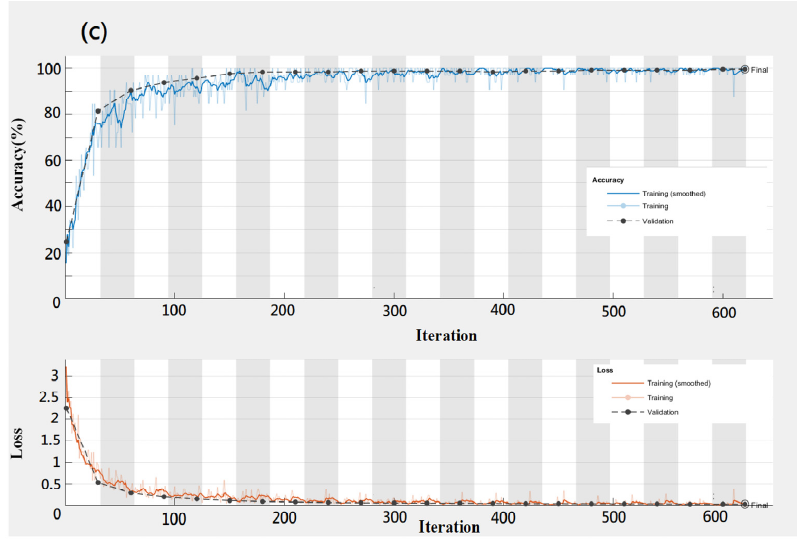
Figure 13. Accuracy and loss training map of feature data set—( a ) VGG16, ( b ) GoogLeNet ( c )